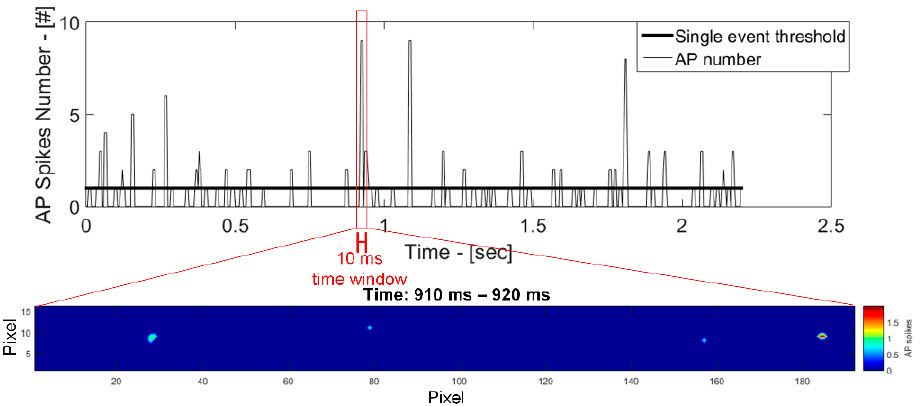
Figure 17. Neuronal spikes map of action potential bursting.